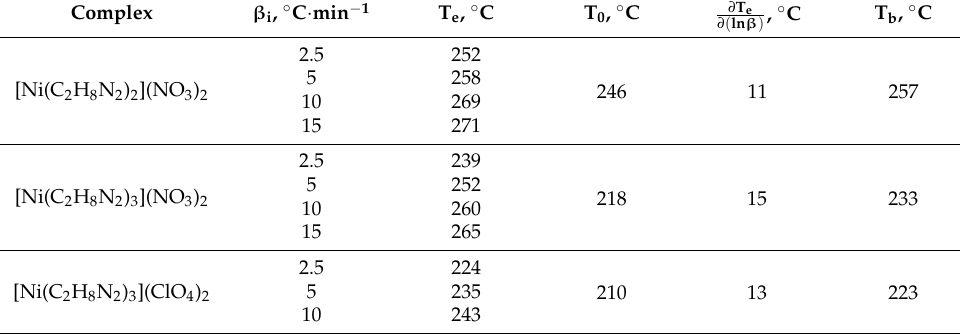
The onset temperature and the critical temperature of the thermal explosion